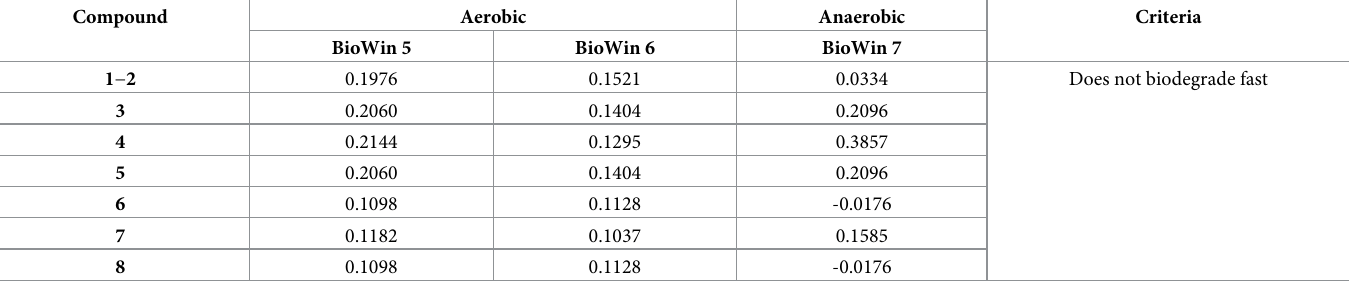
Table 6. Biodegradability of IBP and its biotransformation products calculated using EPI Suite. Compound